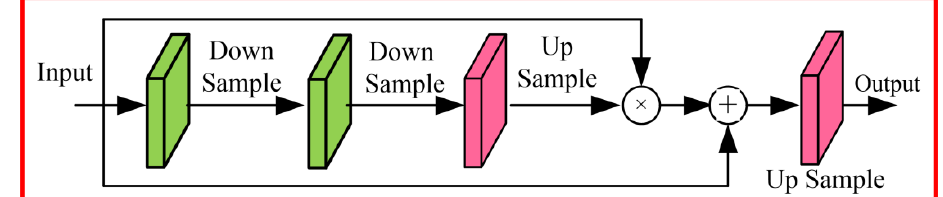
where the dilated convolution branch can capture the features of larger size, and each branch independently updates its scaling and shifting parameters to enhance model adaptability. To enhance the model’s attention to important features, the ability of the model to extract data is improved. An attention mechanism is introduced into each block, Figure 6. Training network. Figure 6. Training network. as shown in Figure 7.